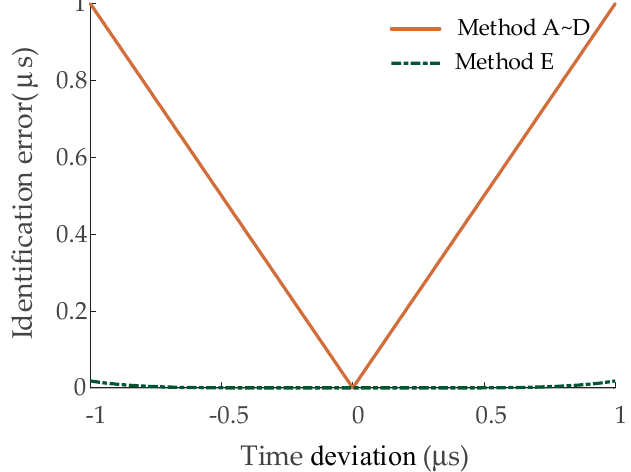
Figure 27. The performances of methods A~E with a time error added to I 1 a . (The ordinate axis represents the absolute value of the identification error).